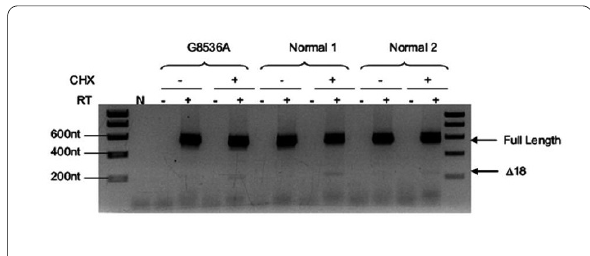
Figure 1 No evidence for altered splicing of transcripts derived from an LCL generated from a BRCA2 c.8308 G > A (p.Ala2770Thr) carrier . LCLs from a carrier of BRCA2 c.8308 G > A (p.Ala2770Thr) or two BRCA2 normal LCL controls were analysed by RT-PCR using primers specific for BRCA2 exons 16 and 19. CHX indicates cycloheximide treat- ment, which was used to examine transcript stability, RT indicates re- verse transcriptase. N indicates no template